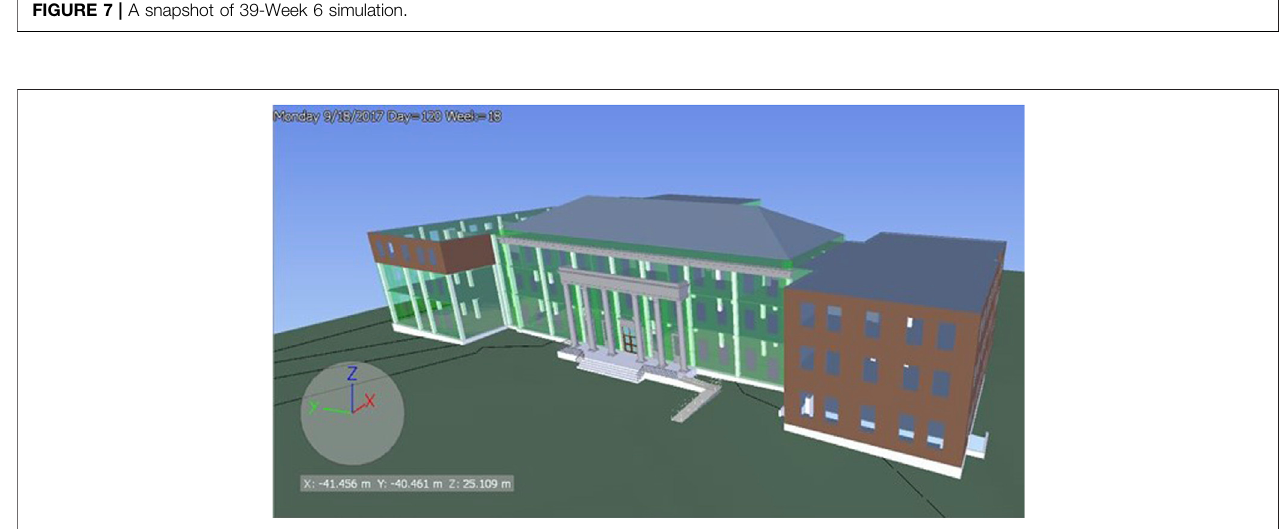
FIGURE 7 | A snapshot of 39-Week 6 simulation.